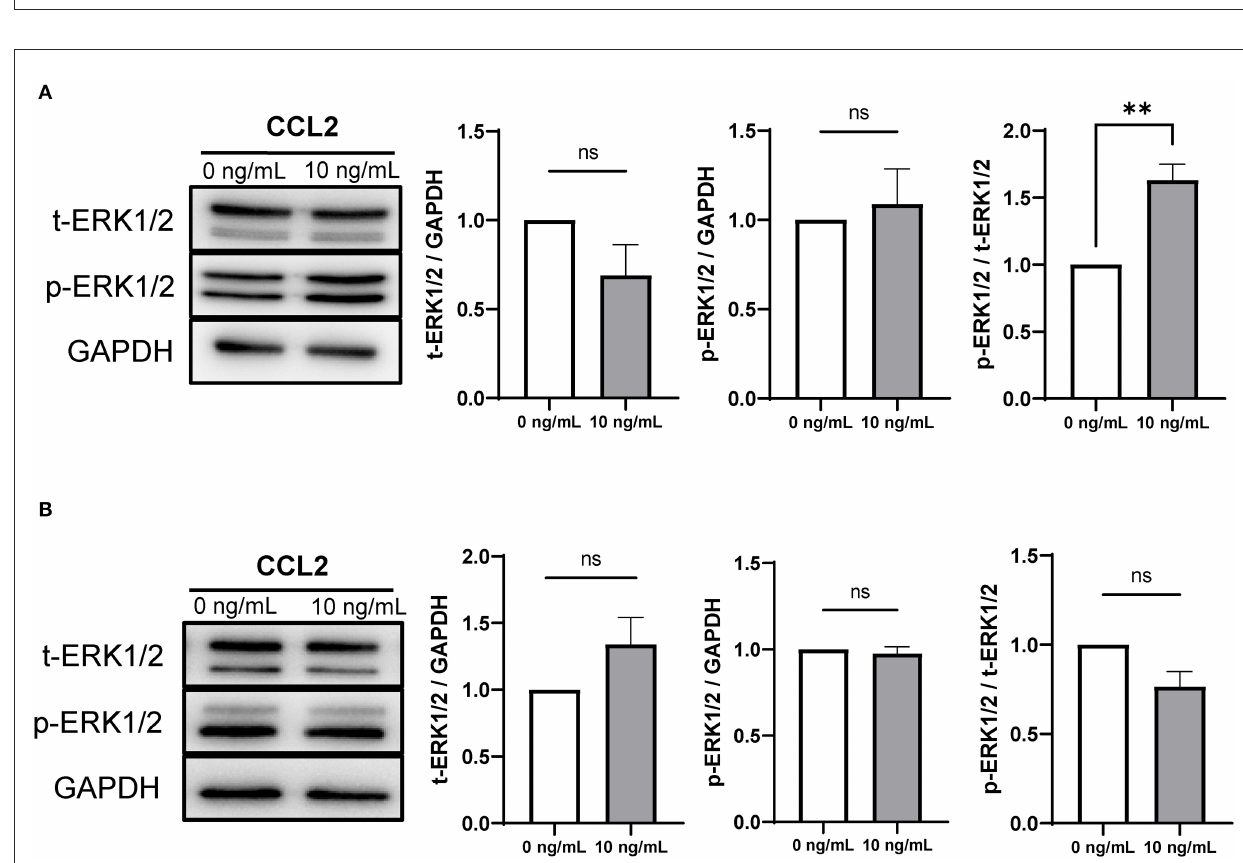
FIGURE6 Expression and phosphorylation levels of ERK1/2 in porcine CCs and oocytes after IVM. Western blots of t-ERK1/2, p-ERK1/2, and GAPDH in CCs (A) and oocytes (B) . Levels of t-ERK1/ 2 and p-ERK1/2 and the ratio of p-ERK1/2 to t-ERK1/2 in CCs and oocytes are shown. The results were normalized to those of GAPDH. Data is represented as mean ± SEM. The experiment was replicated three times. ** p < 0.01; ns, not significant ( p > 0.05).